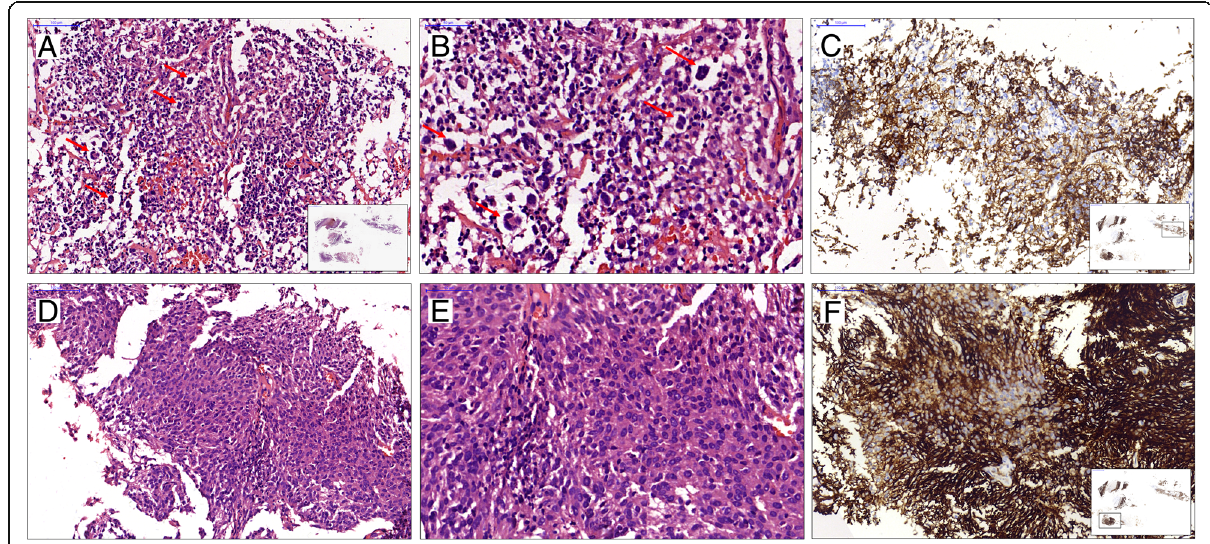
Fig. 4 Case 3: HE staining of core needle biopsy specimen shows 2 different histopathological morphologies: one is that in the inflammatory background, there are scattered large round or ovoid cells resembling lacunar Reed-Sternberg cells ( a , b , arrows, inset: low-power view of needle biopsy), another presents ovoid and spindle tumor cells with bundles and woven patterns ( d , e ), both of which are positive for CD23 ( c , f ,